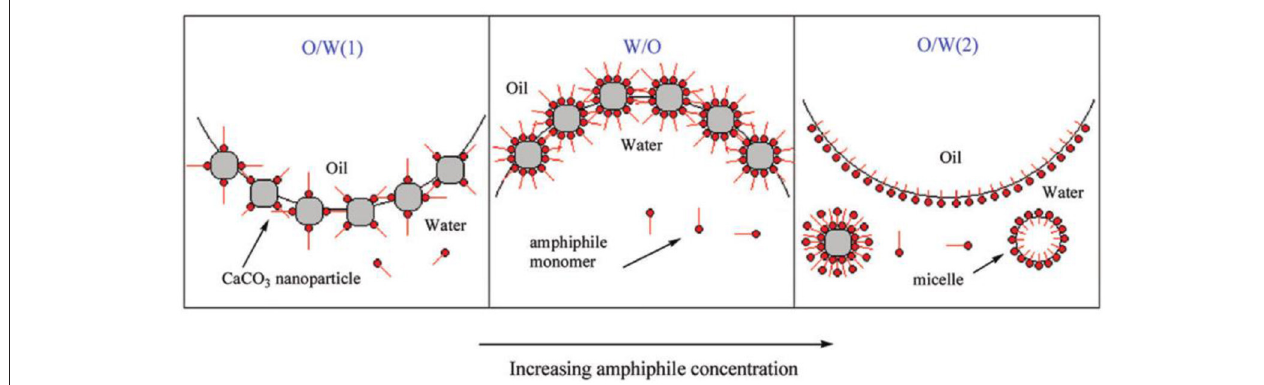
FIGURE 2 | Schematic representation of phase inversion induced by the adsorption of sodium carboxylates onto CaCO 3 nanoparticles (Cui et al., 2012). Reprinted with permission from Cui et al. (2012). Copyright 2012 American Chemical Society.